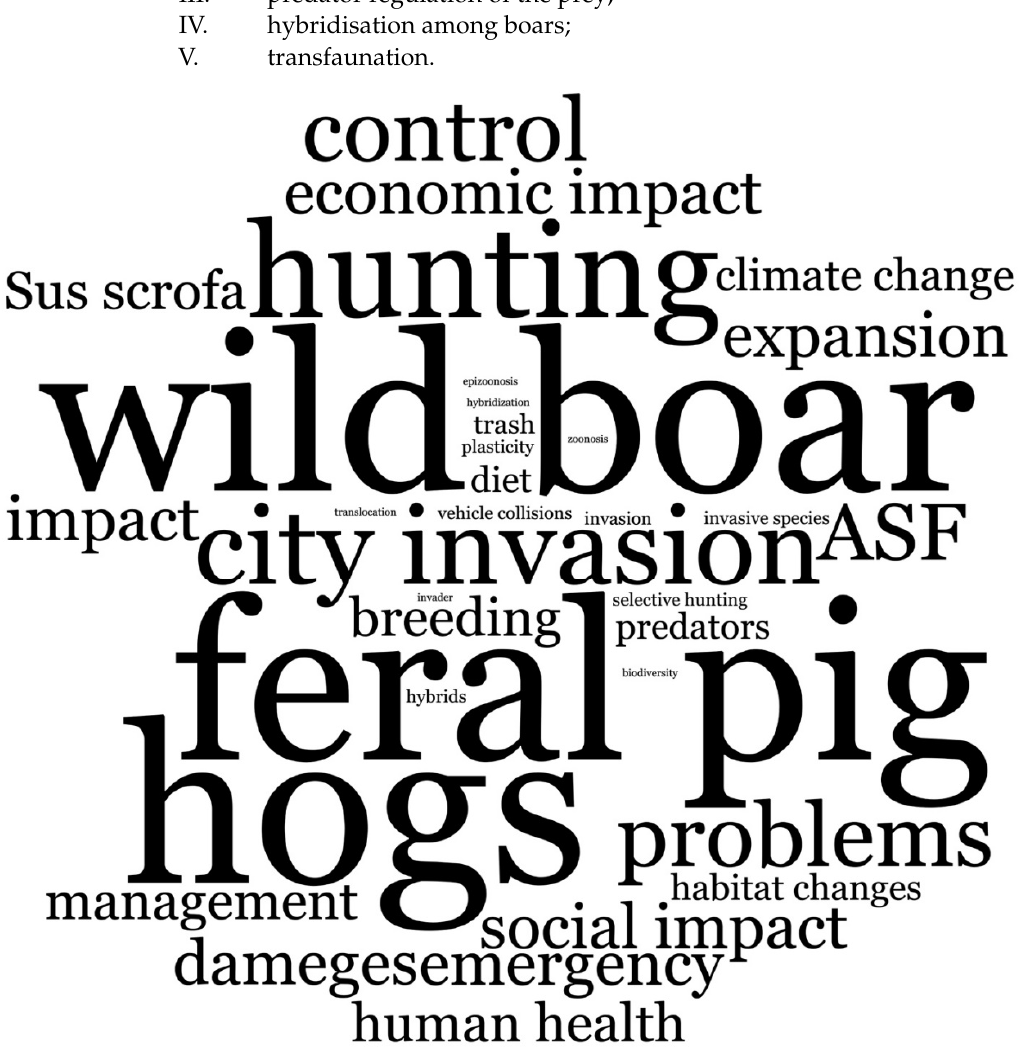
Figure 1. Word Cloud graph performed with a free online word cloud generator available at Word- clouds.com (accessed on 20 April 2022), using 35 keywords considering an investigation referring to the wild boar, hybrid and feral